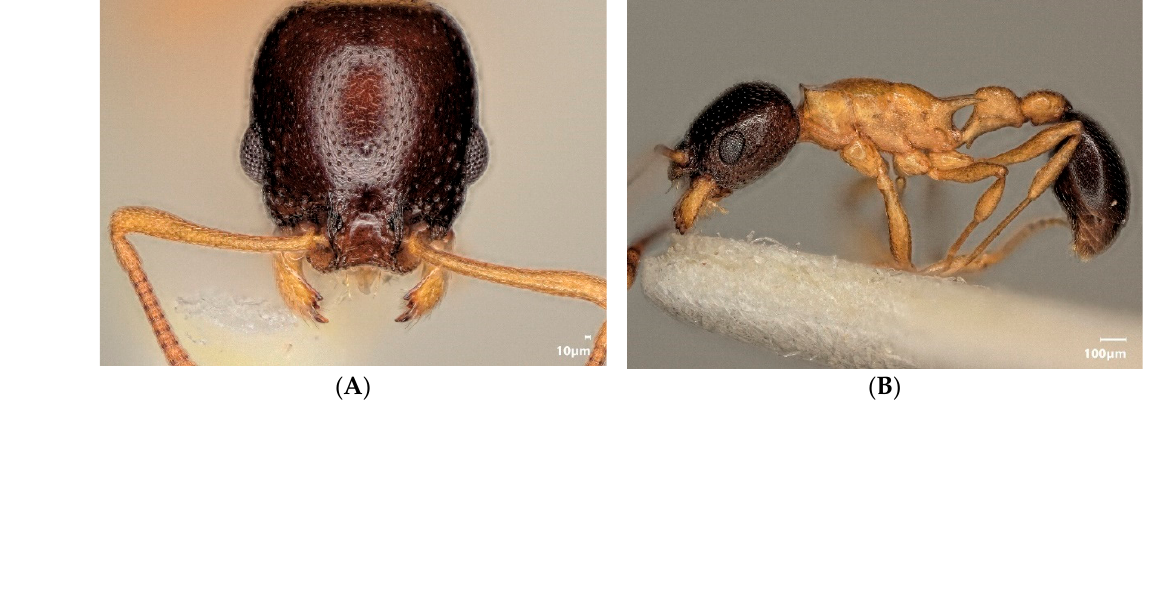
Figure 21. Cardiocondyla nigrocerea : head in dorsal view: ( A ), lateral view ( B ), dorsal view ( C ).